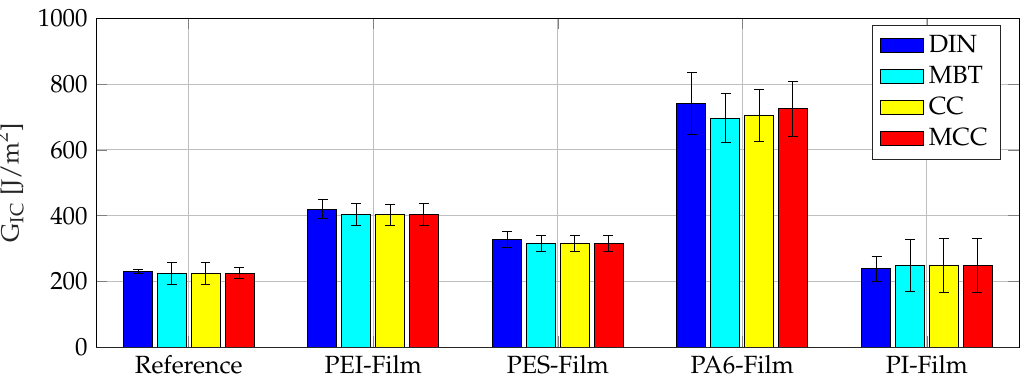
Figure 10. Influence of thermoplastic films on the mode I critical energy release